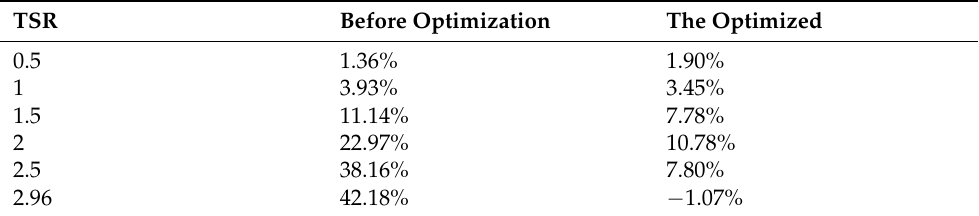
Table 7. Changes of wind energy capture rate of two-dimensional offshore wind turbines before and after